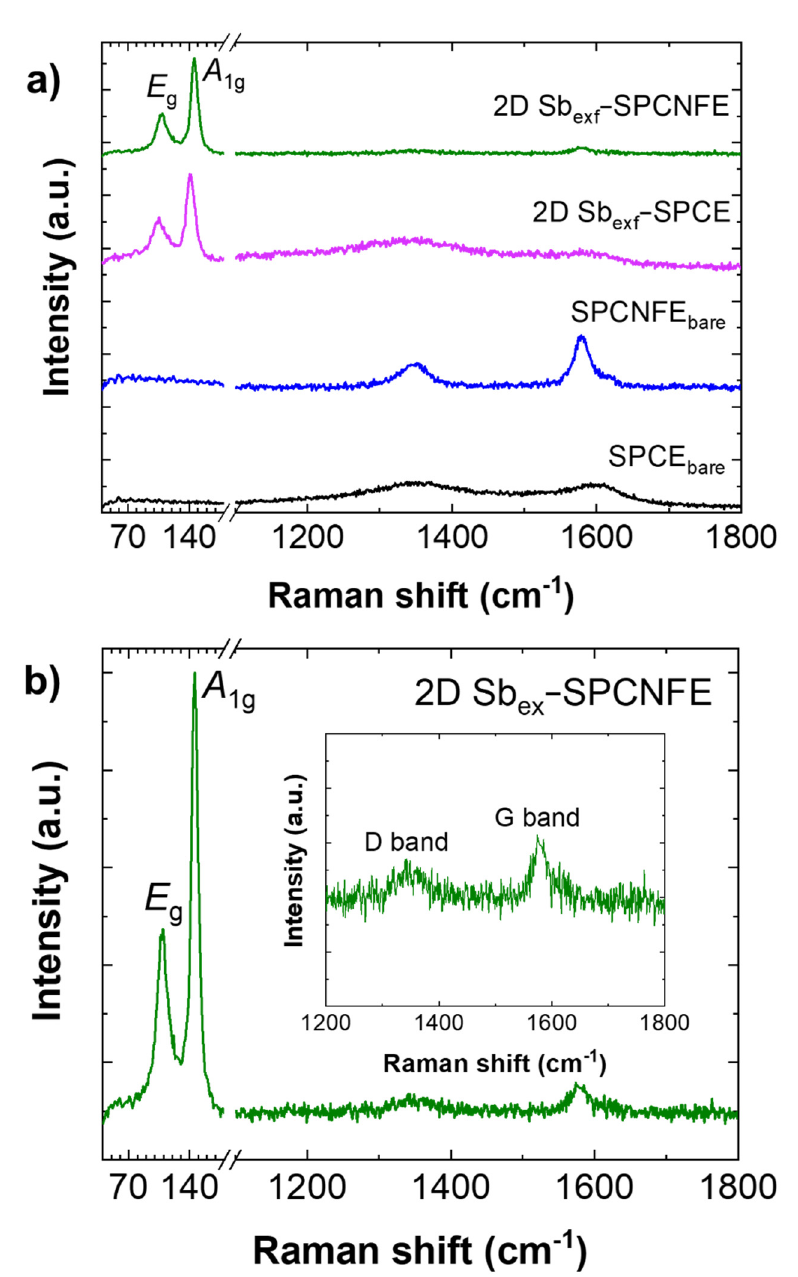
Figure 2. ( a ) Raman spectra of 2D Sb exf − SPCNFE compared to other modi fi ed SPCEs with the representation of phonon frequencies of the E g and A 1g modes characteristic of antimony. ( b ) Detail of the Raman spectrum of 2D Sb ex − SPCNFE with an inset showing the D − and G − bands.